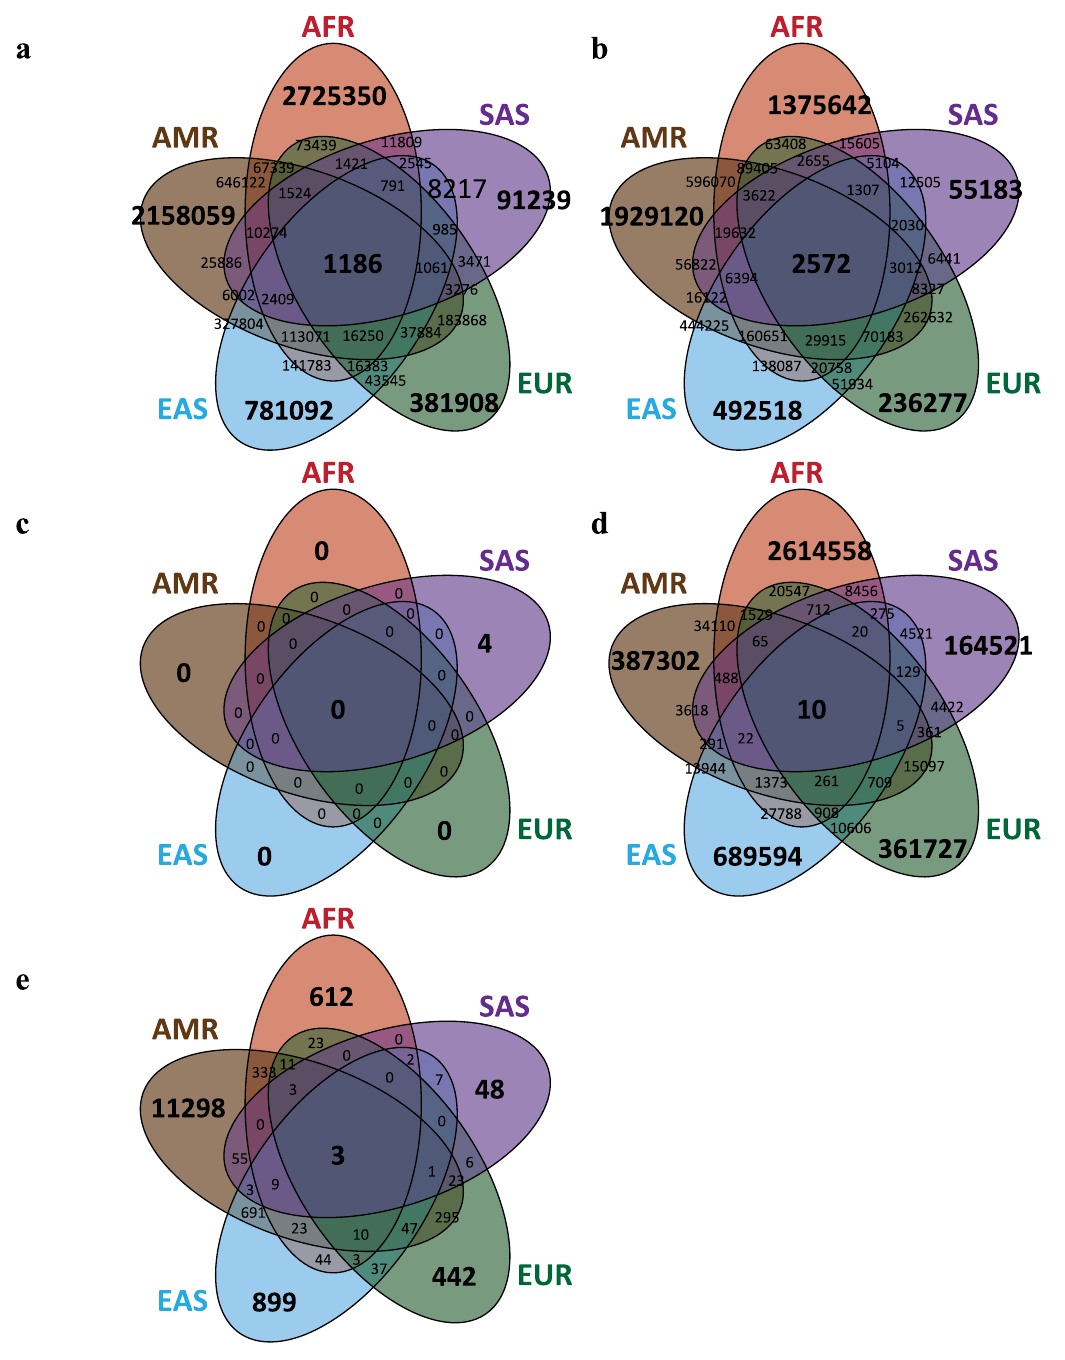
Fig. 7 Distribution of ancestry informative markers (AIMs) and ancestry informative genes (AIGs). a SNV-based AIMs. b SNP-based AIMs. c RV-based AIMs. d SNP/RV-based AIMs. e AIGs under homozygosity disequilibrium (HD). FIN, CEU, GBR, IBS, and TSI, respectively; the maximum dif- signi fi cantly different allele frequencies within the East Asian- ancestry group (adjusted P = 4.157 × 10 – 3 in Fisher ’ s exact test, Δ = 0.332) and signi fi cantly different allele frequencies within the European-ancestry group (adjusted P = 7.479 × 10 – 3 in Fisher ’ s exact test, Δ = 0.195). In the East Asian-ancestry group, the allele frequencies of T were 0.134, 0.192, 0.286, 0.380, and 0.466 in CDX, KHV, CHS, JPT, and CHB, respectively; the maximum difference was Δ = 0.332. In the European-ancestry group, the allele frequencies of T were 0.727, 0.702, 0.676, 0.556, and 0.533 in COMMUNICATIONS BIOLOGY| (2021) 4:171